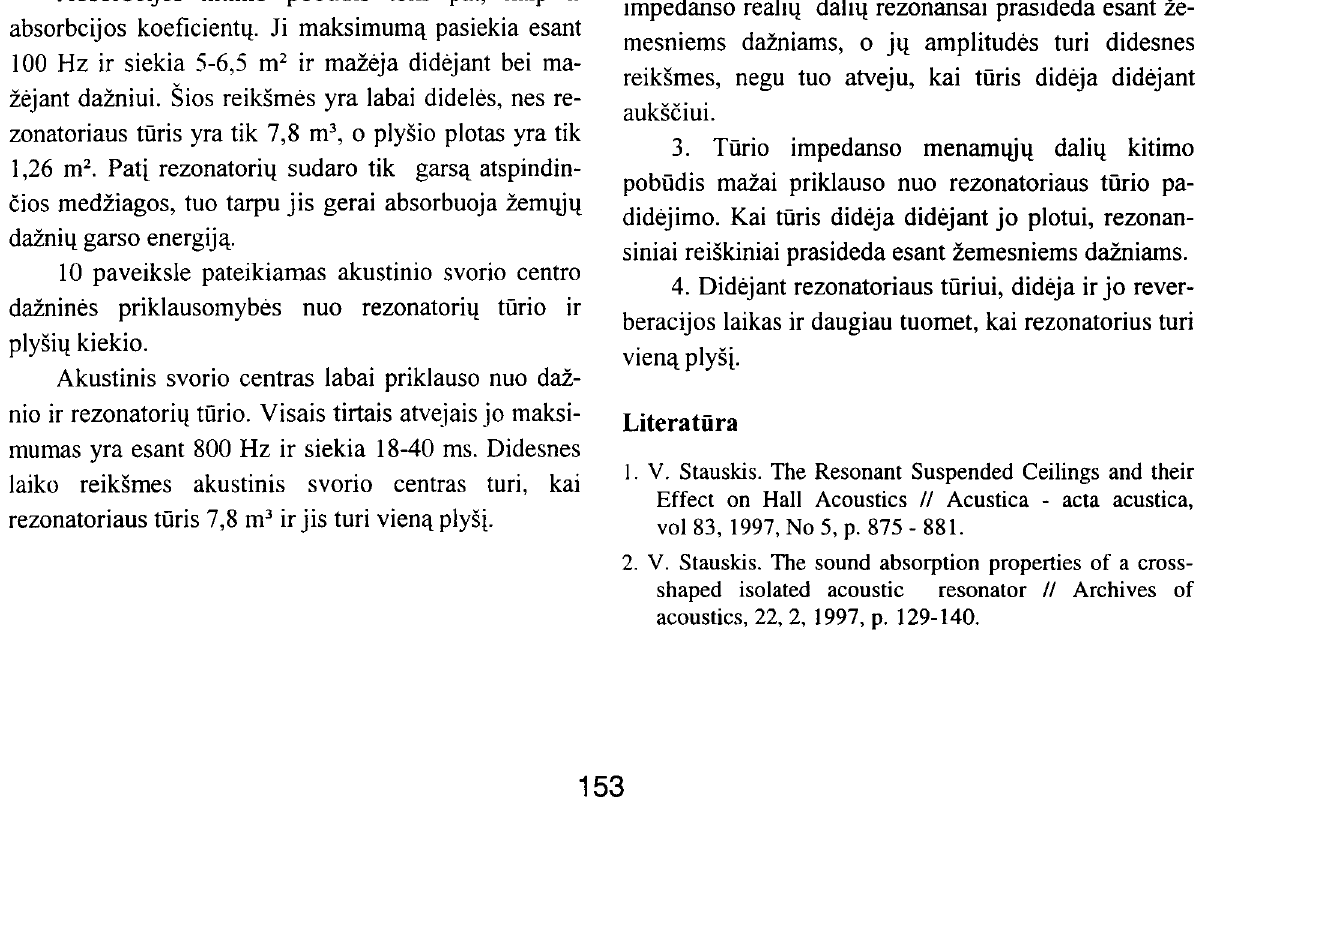
Fig 9. The frequency characteristics of the sound absorption coefficients dependent on the volume of resonators and the number of slits: I - volume 2.6 m 3 with one slit; 2 - the same with two slits; 3- volume 7.8 m 3 with one slit; 4- the same with two slits